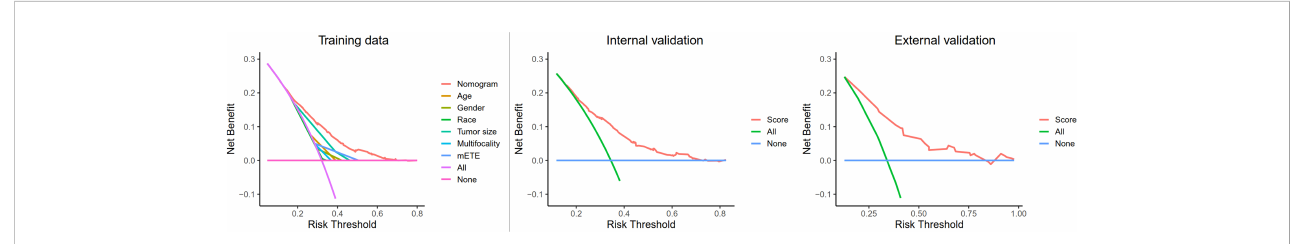
FIGURE 5 Decision curve analysis for CLNM in T1-T2 PTC patients with no LLNM in the training cohort, internal cohort, and external cohort. Net bene fi t = (true positives/N) − (false positives/N) * (weighting factor); Weighting factor = Threshold probability/(1 − threshold probability); CLNM, central lymph node metastasis; LLNM, lateral lymph node metastases; mETE, minimal extrathyroidal extension.